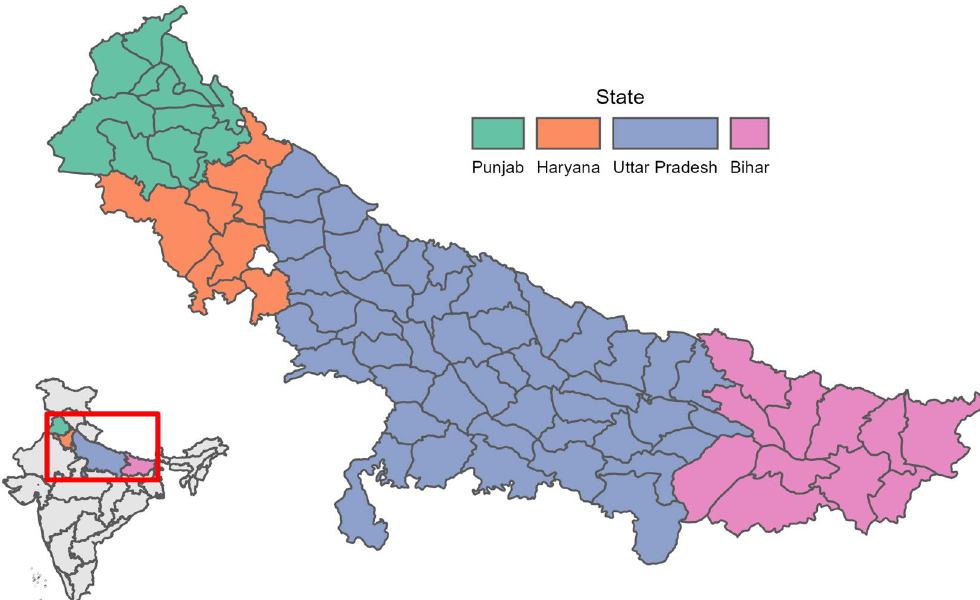
Figure 1. Colours represent the four states of the IGP in this study. Further divisions by black lines represent 1966 district boundaries. Districts in grey have been removed from analysis due to their urban or mountainous geography (see supplementary information).